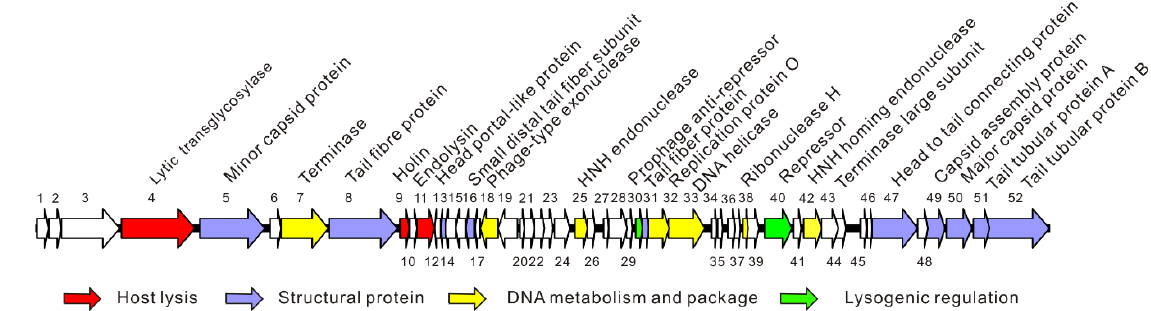
Figure 2. Schematic diagram of the genome of phage vB_EcoM_APEC. The different colors indicate the functional classification of the genes.